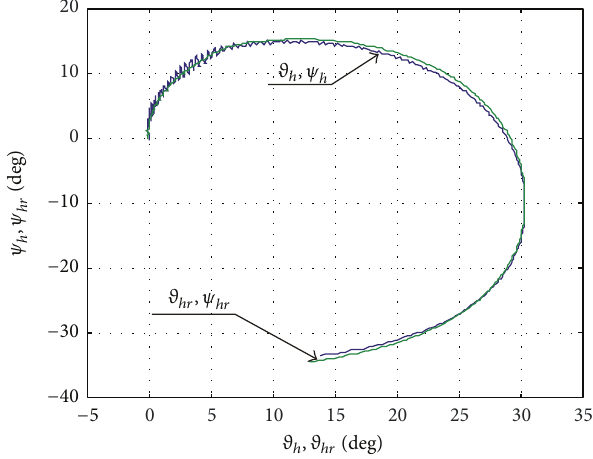
Figure 14: Time-dependent real 𝜗 ℎ ,𝜓 ℎ and desired 𝜗 ℎ𝑟 , 𝜓 ℎ𝑟 angles specifying the location of the head axis for optimum controls with the influence of